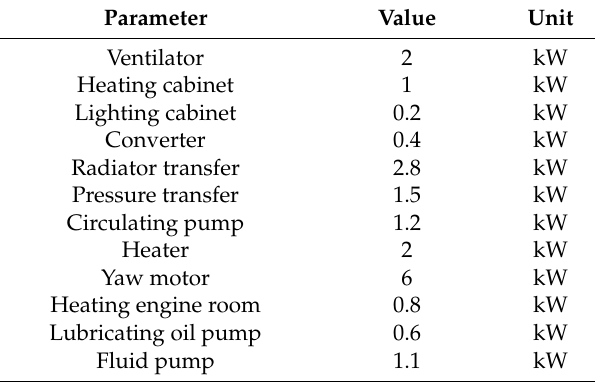
Table 2. The parameters of